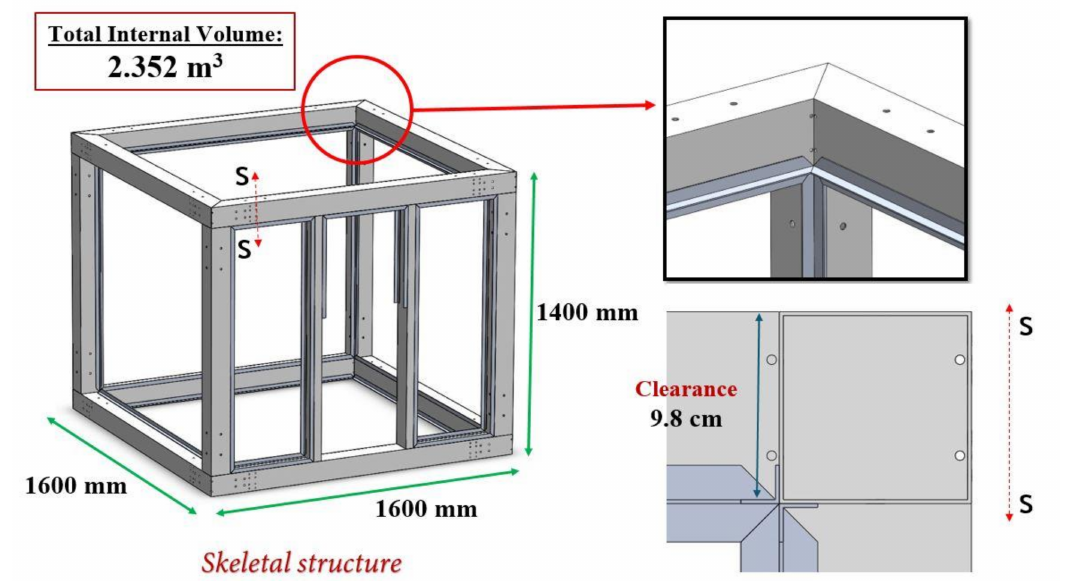
Figure 15. Skeletal structure of the prototype and its